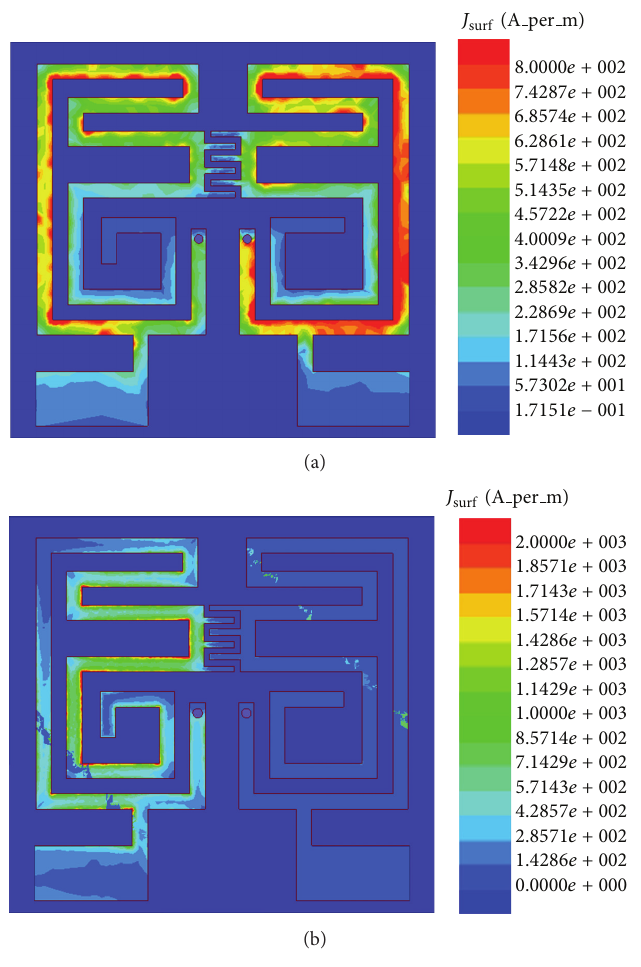
Figure 4: Current distribution: (a) fundamental frequency and (b) the third harmonic.